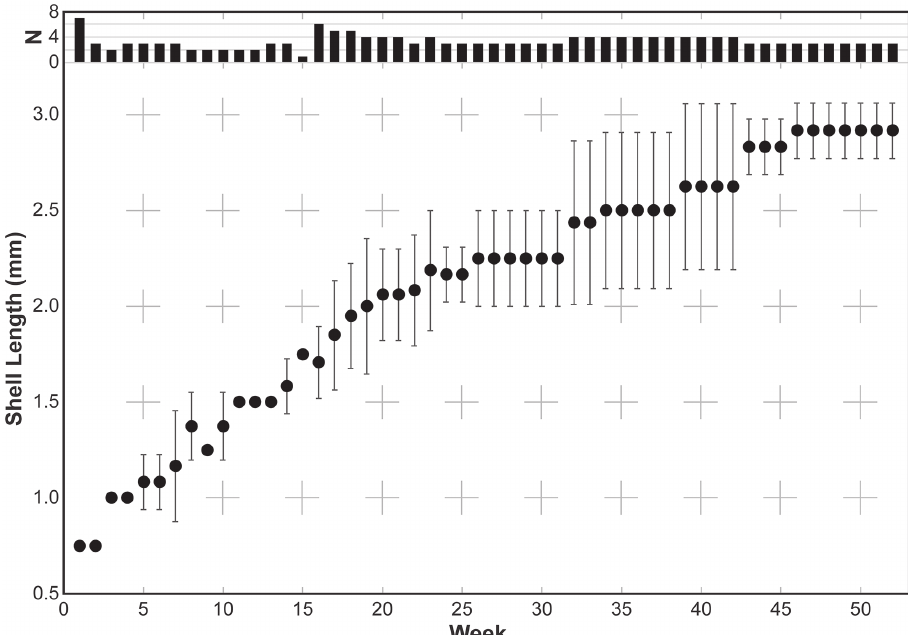
Figure 3. Growth profile of Fontigens antroecetes held under simulated cave conditions for up to 52 weeks post hatching. Error bars represent +/- one standard deviation. Histogram indicates number of individuals measured at each week interval.